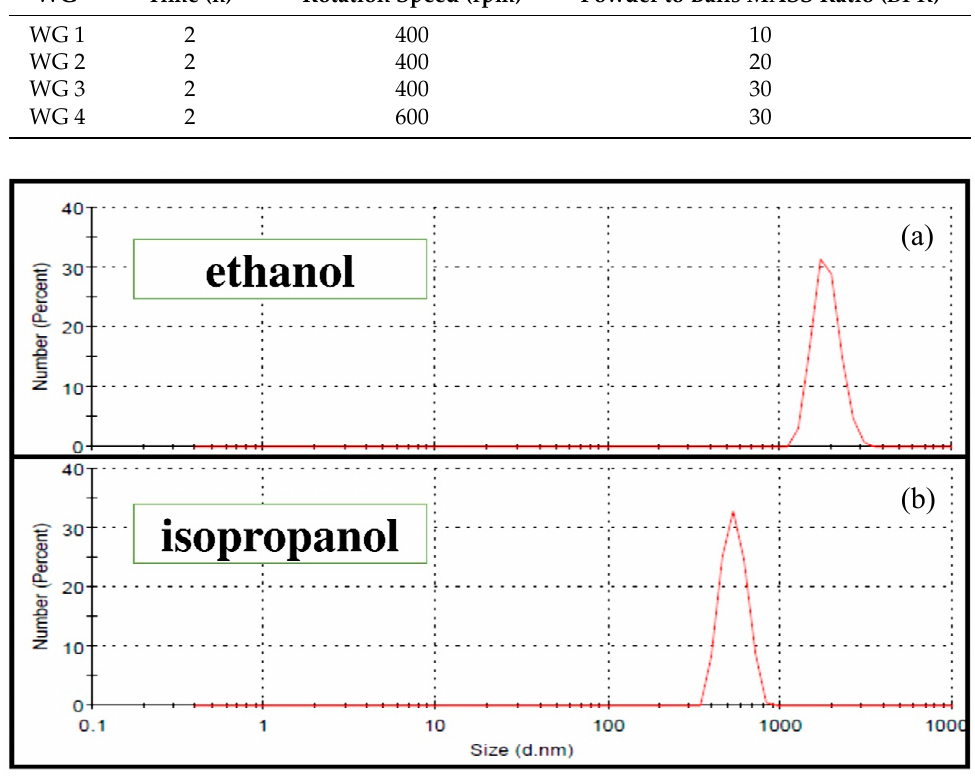
Figure 7. Particle size distributions of the 45S5 Bioglass ® powder after the optimal Wet grinding WG4 (see Table 2): ( a ) ethanol; ( b ) isopropanol.